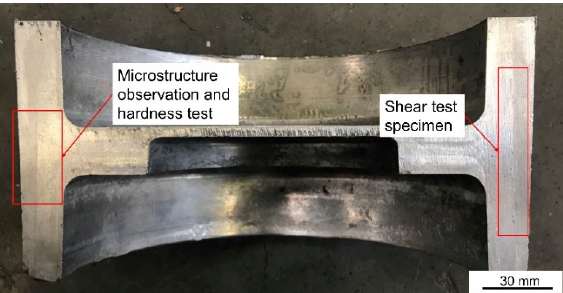
Figure 7. Physical diagram of cross-section of the brake drum and its sampling position and function.